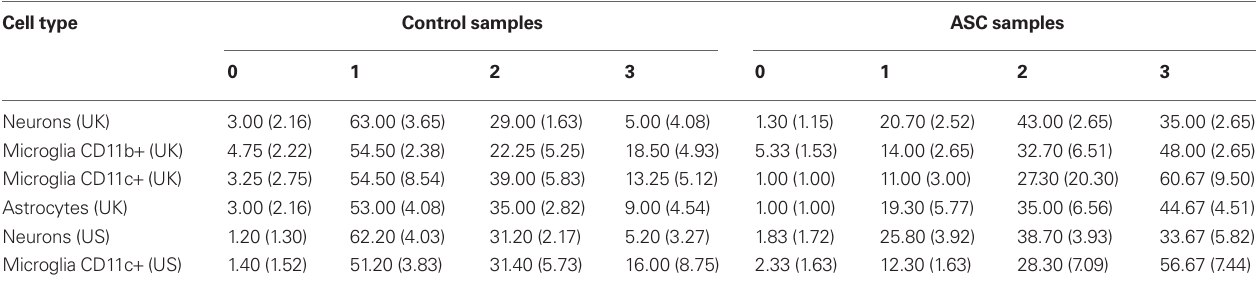
Values are mean (across samples, with standard deviation) percentage of cells demonstrating corresponding staining.